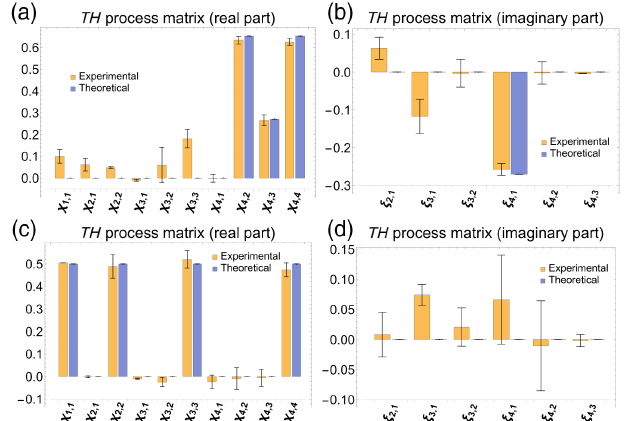
FIG. 13. Tomographic reconstruction of TH unitary operator. From top left to bottom right: (a),(b) real and imaginary parts of process matrix, given correct decryption, and (c),(d) real and imaginary parts of process matrix, given wrong decryption.